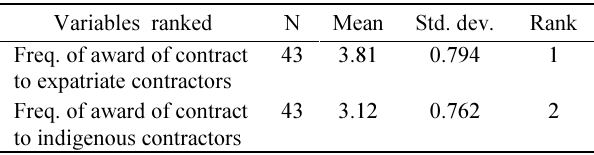
Table 1. Ranking of the frequency of award of contracts to indigenous and expatriate contractors in